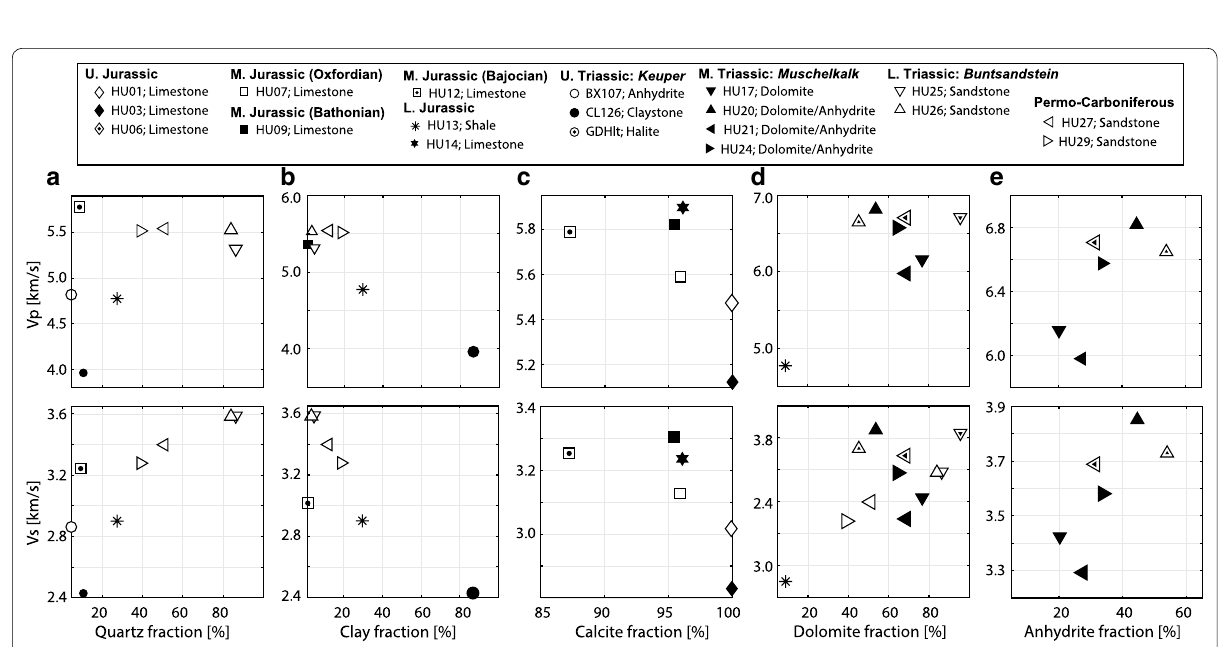
Fig. 13 Average seismic velocity of compressional and shear-waves are plotted against the content of various rock-forming minerals. It shows that the compressional velocities decrease with increasing quartz and clay content, while for shear waves the correlation is opposite for quartz (decrease) than for clay (increase). Despite a certain dispersion of the data, that we interpret as due to factors such as alterations and diagenesis, we observe a positive correlation between velocities (P- and S-waves) and dolomite content. Less evident is the correlation of velocities with calcite content and with evaporitic minerals. Error bars are within